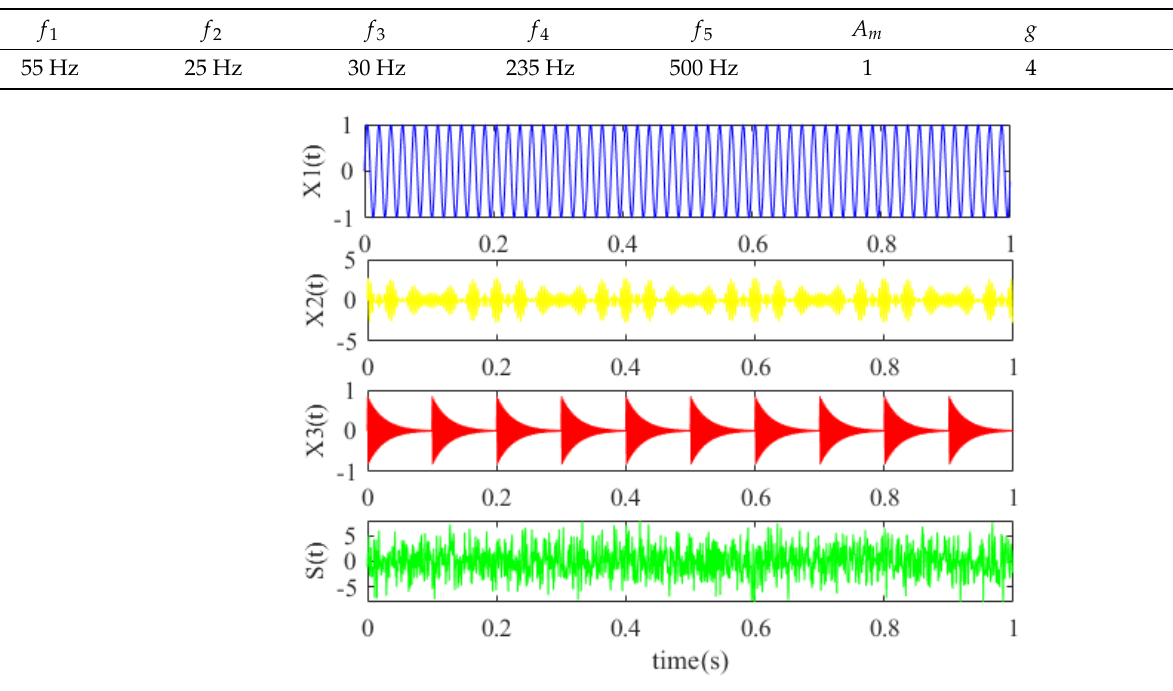
Figure 7. The time-domain waveforms of the constructed signals. The key parameters of MOPSO are set as